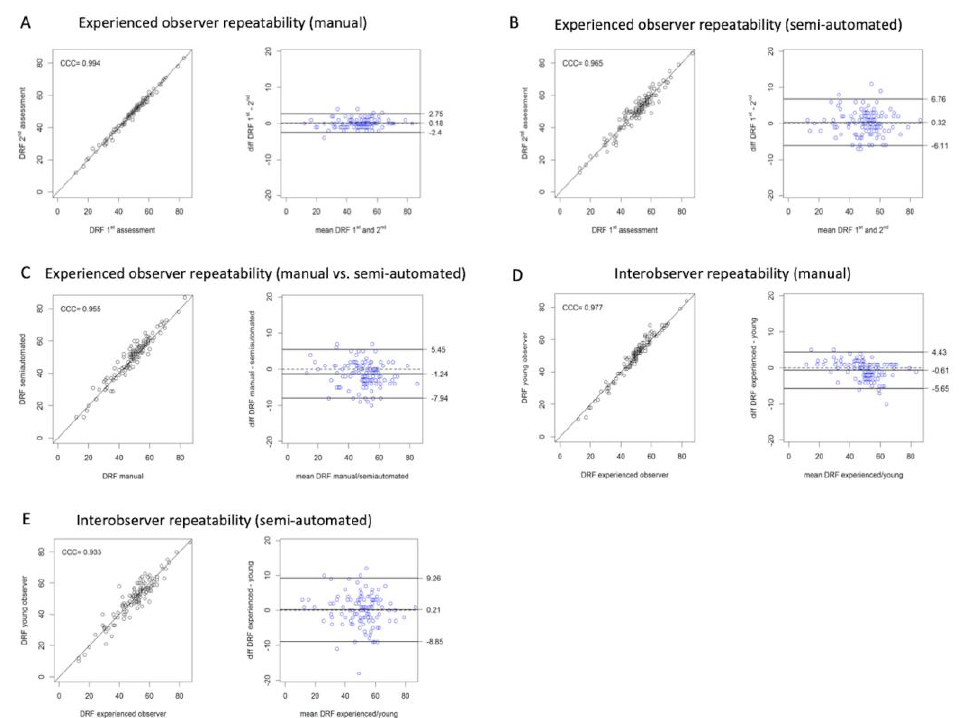
Figure 1. DRF of the left kidney calculated with the manual and semi-automated approaches. Correlation (left columns) and Bland–Altman (right columns) plots of: intra-observer repeatability for the experienced radiographer with the manual approach ( A ), semi-automated approach ( B ), manual vs. semi-automated approaches ( C ), inter-observer repeatability with the manual ( D ) and semi-automated approach ( E ). DRF, di ff erential renal function (%); CCC, Lin’s concordance correlation coe ffi